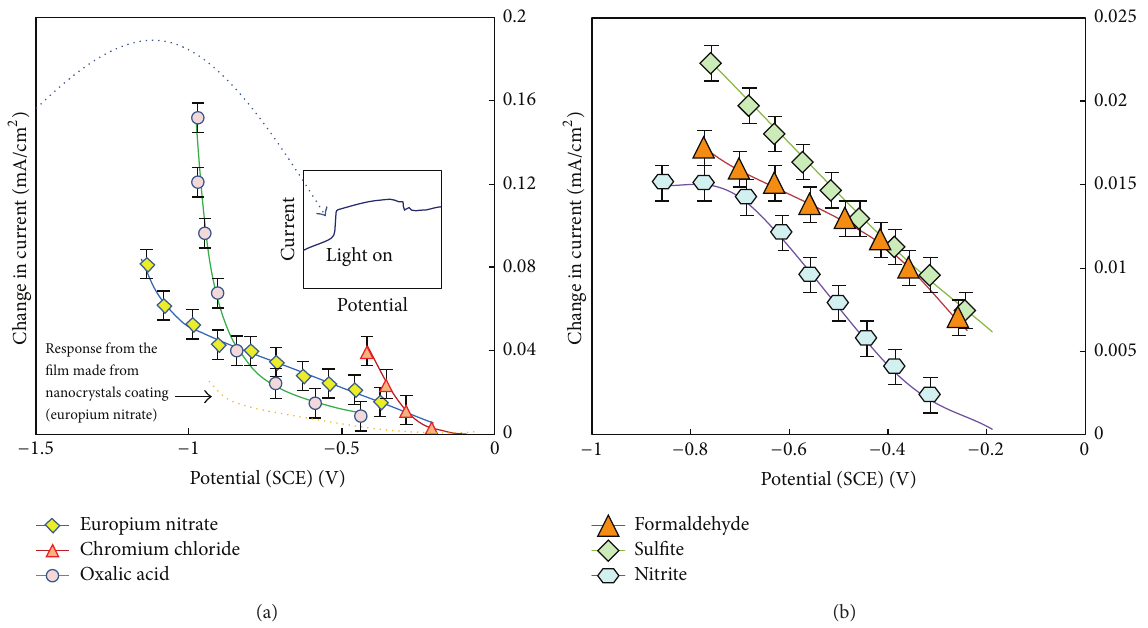
Figure 4: Average photoelectrochemical response of CZTS thin film in different redox electrolytes, change in current during illumination is shown in